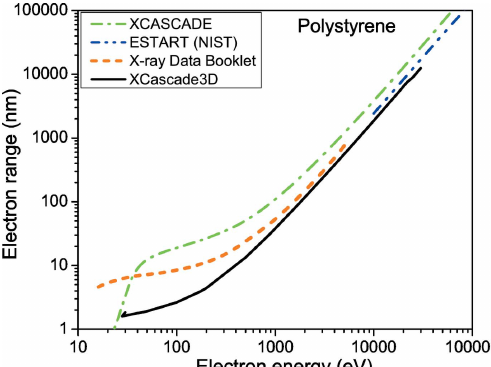
Figure 1 Electron range in polystyrene according to XCascade3D simulations – solid black line; XCASCADE estimation within the continuous-slowing- down approximation – green dash-dotted line; energy loss function integral from the NIST database – blue dash-dot-dotted line (Berger et al. , 1998); X-ray Data Booklet – orange short-dashed line (Thompson et al. ,